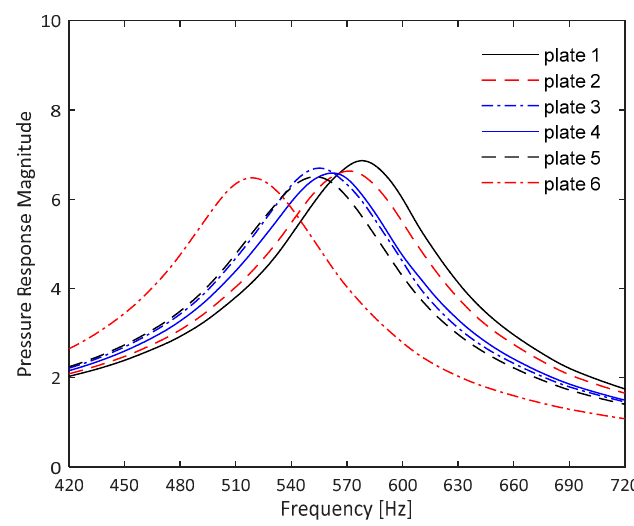
Figure 15. Experimental pressure response functions for plate 1 to plate 6.